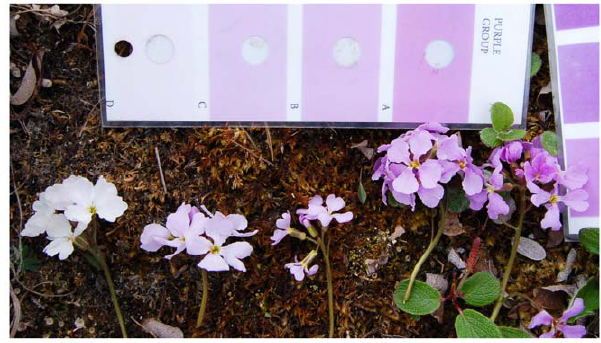
Figure 1. Flower color variation. Flower color is highly variable within this population of Parrya nudicaulis . A gradient of violet-purple coloration increases from pure white flowers on the left to dark violet flowers on the right. A Royal Horticultural Society Color Chart serves in the background for comparison.